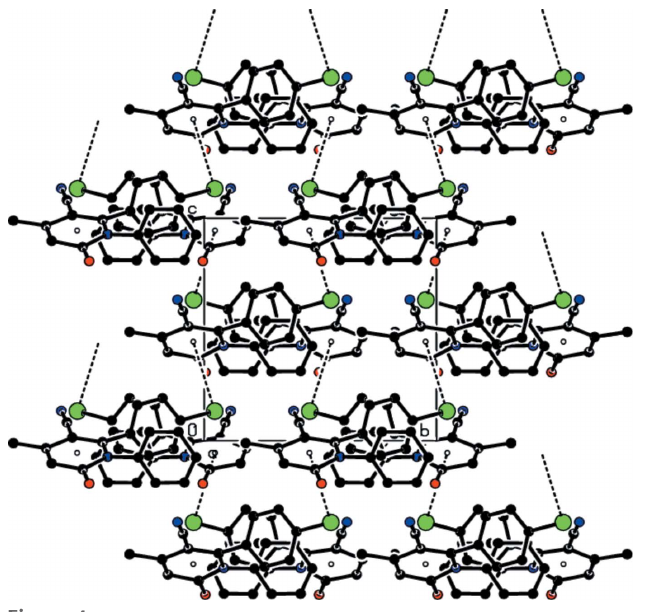
Figure 4 Packing view of the title compound along the a axis showing the C— Br (cid:2)(cid:2)(cid:2) (cid:2) interactions as dashed lines.